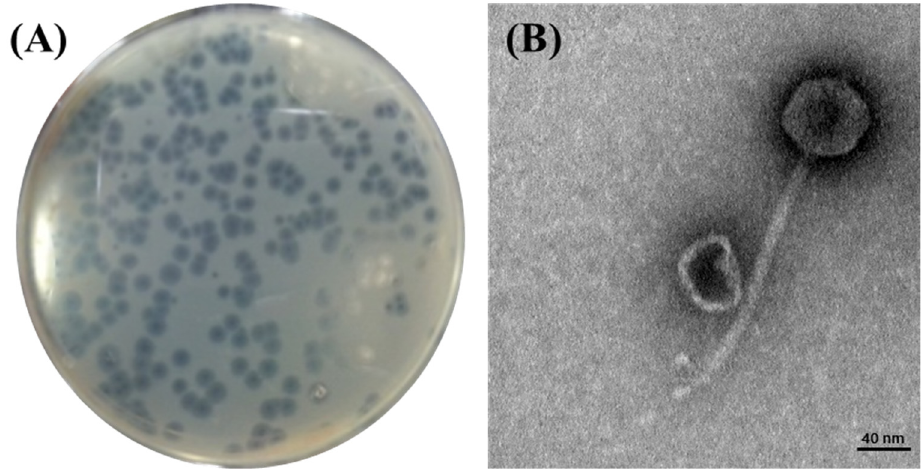
Figure 1. Plaque and TEM morphology of the phage, BECP10. ( A ) Plaques formed on E. coli NCTC 12079 by phage BECP10. ( B ) TEM morphology of phage BECP10.